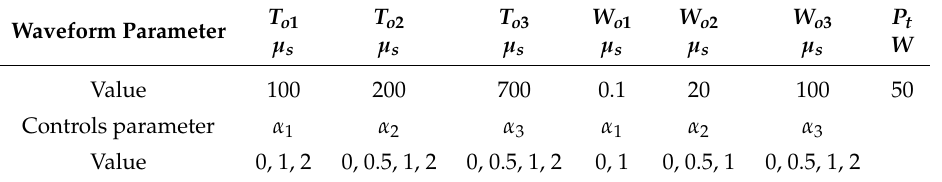
Table 1. Transmission signal reference parameter setting table.